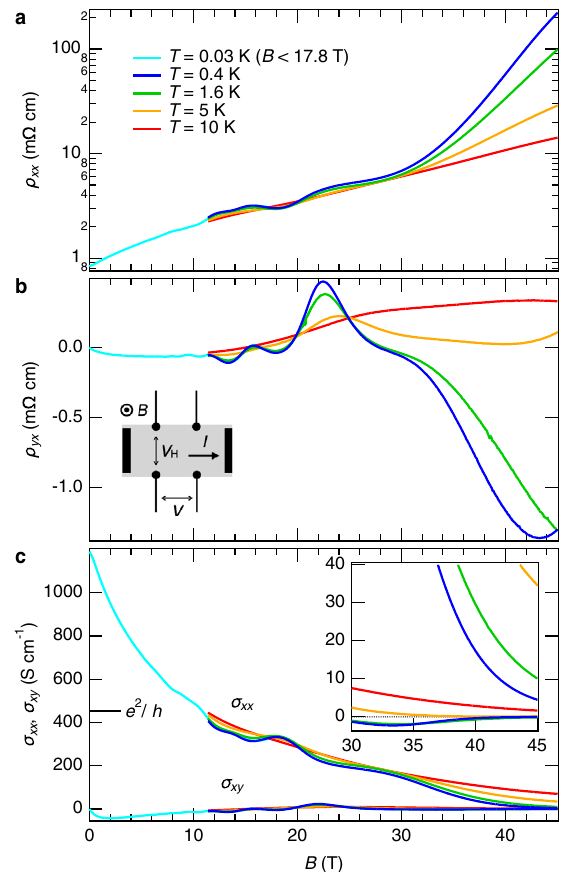
Fig. 2 Magnetotransport in CaFeAsF in fi elds up to B = 45 T applied along the c axis. a The longitudinal resistivity ρ xx and ( b ) the Hall resistivity ρ yx . The inset in ( b ) shows a schematic of the sample. c The longitudinal conductivity σ xx and Hall conductivity σ xy . The conductivity corresponding to one conductance quantum e 2 / h per FeAs layer is indicated. The inset shows the blow-up of the high- fi eld region. In ( a , b , and c ) the T = 0.03 K curves (cyan) almost coincide with the T = 0.4 K ones (blue) and hence almost indiscernible above B = 11.4